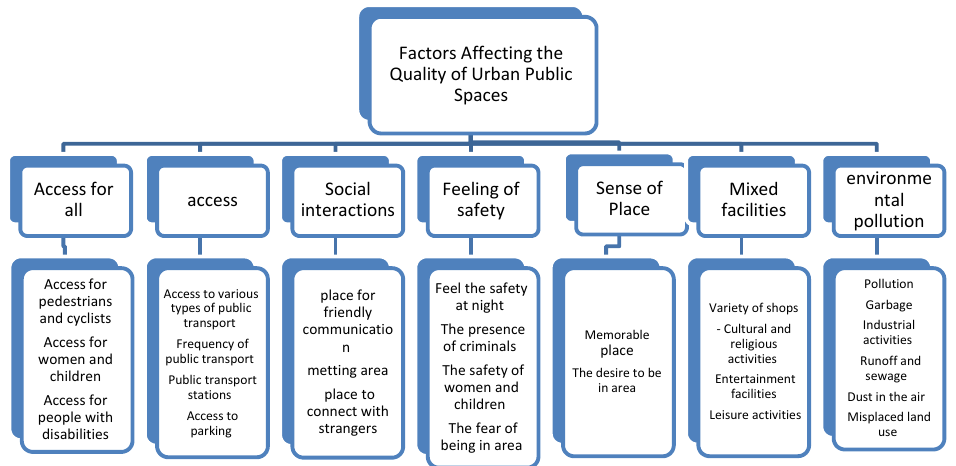
Fig. 1, Evaluation variables and factors ( Meshkini et al.,